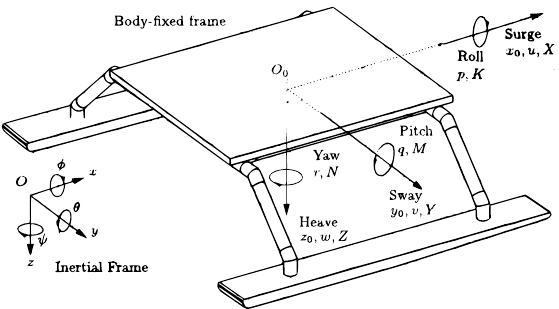
Figure 4. Standard notation and sign conventions for ship motion description on the Strider